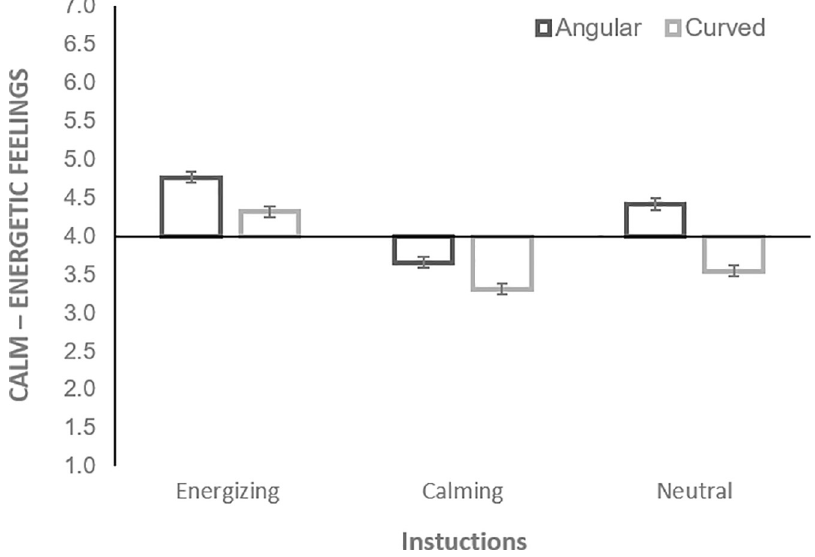
Fig 9. Energizing vs. calming effects of angular vs. curved pills in Study 3b. The bars represent SE.